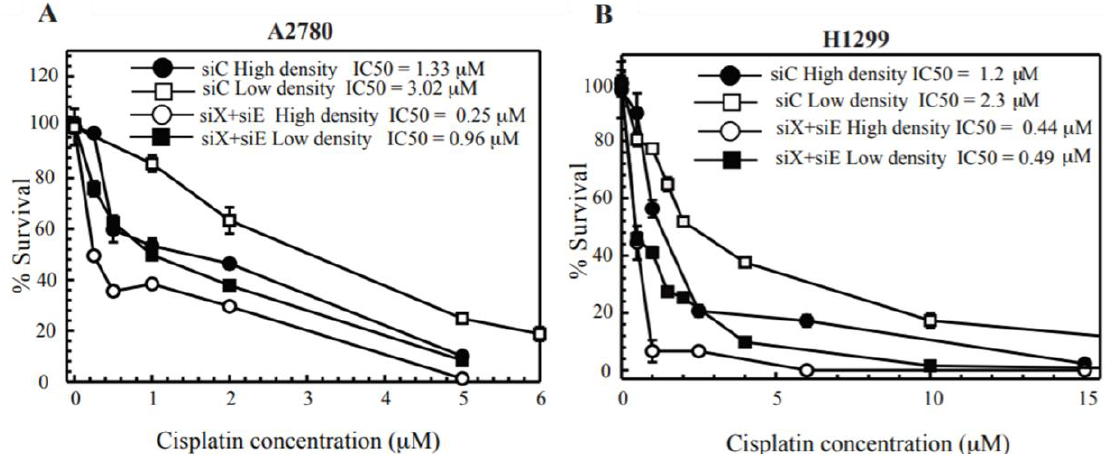
Figure 5. Clonogenic survival in ERCC1/XPF knockdown cells on cisplatin treatment at low and high density of cells. ( A ) A2780 and ( B ) H1299. Non-targeting siRNA (siC) and ERCC1-XPF siRNA transfected cells (siX + siE) transfected cells were treated to cisplatin at high density and low density and plated for colony survival as described in the methods section. Calculated IC 50 values are represented in each figure for each cell line. Values are represented as mean ± SEM from three independent experiments.